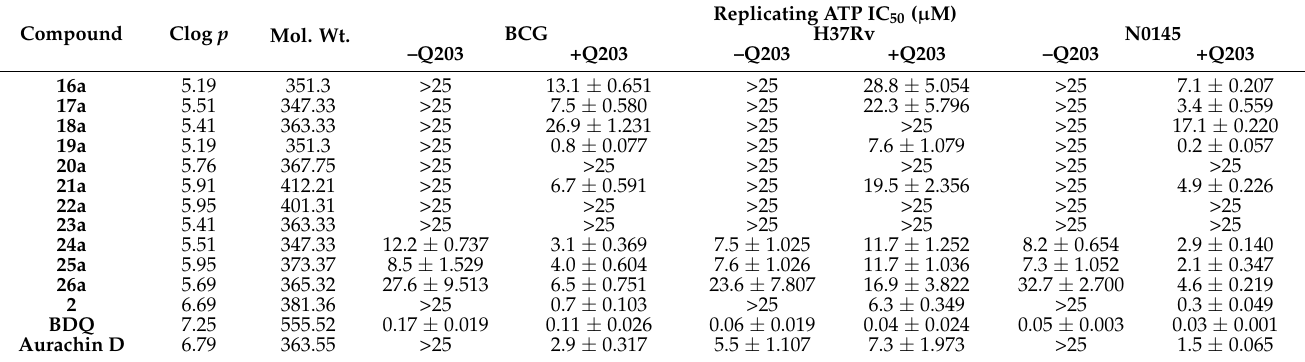
Table 2. Screening of the second set of N -phenethylquinazolin-4-amines 16a – 26a against cyt- bd of M. bovis BCG and M. tuberculosis H37Rv by ATP readout along with known inhibitors ND-11992 ( 2 ), aurachin D and bedaquiline (BDQ) as positive